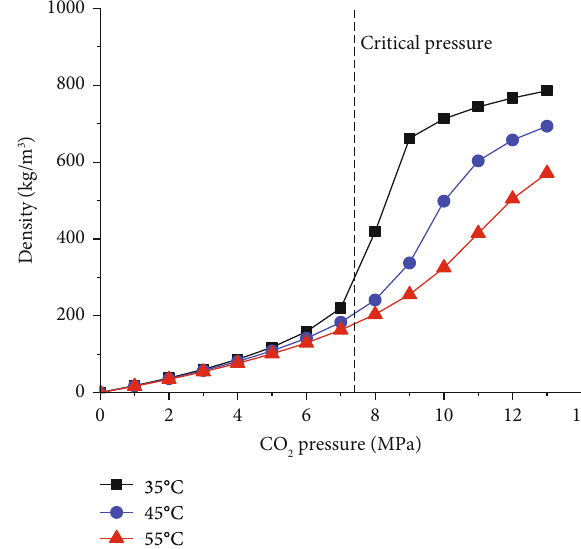
Figure 6: CO density at di ff erent temperatures and 2